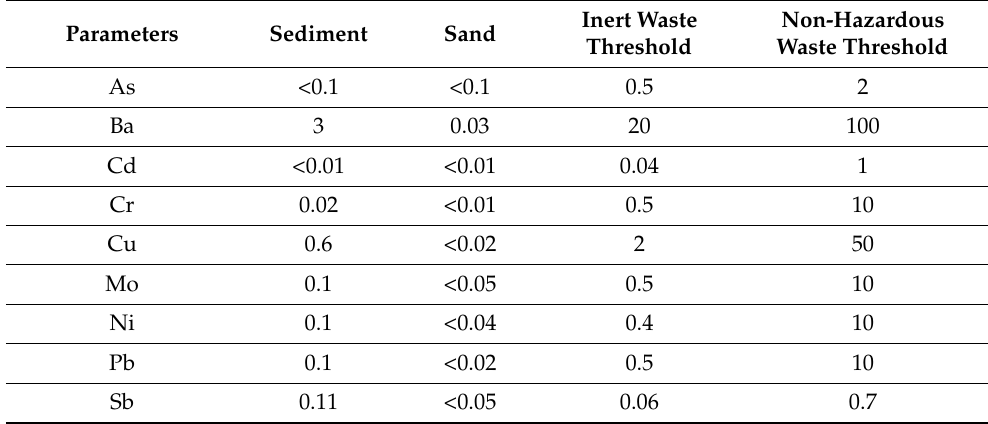
Table 5. Leaching test results of raw sediments and sand according French regulation